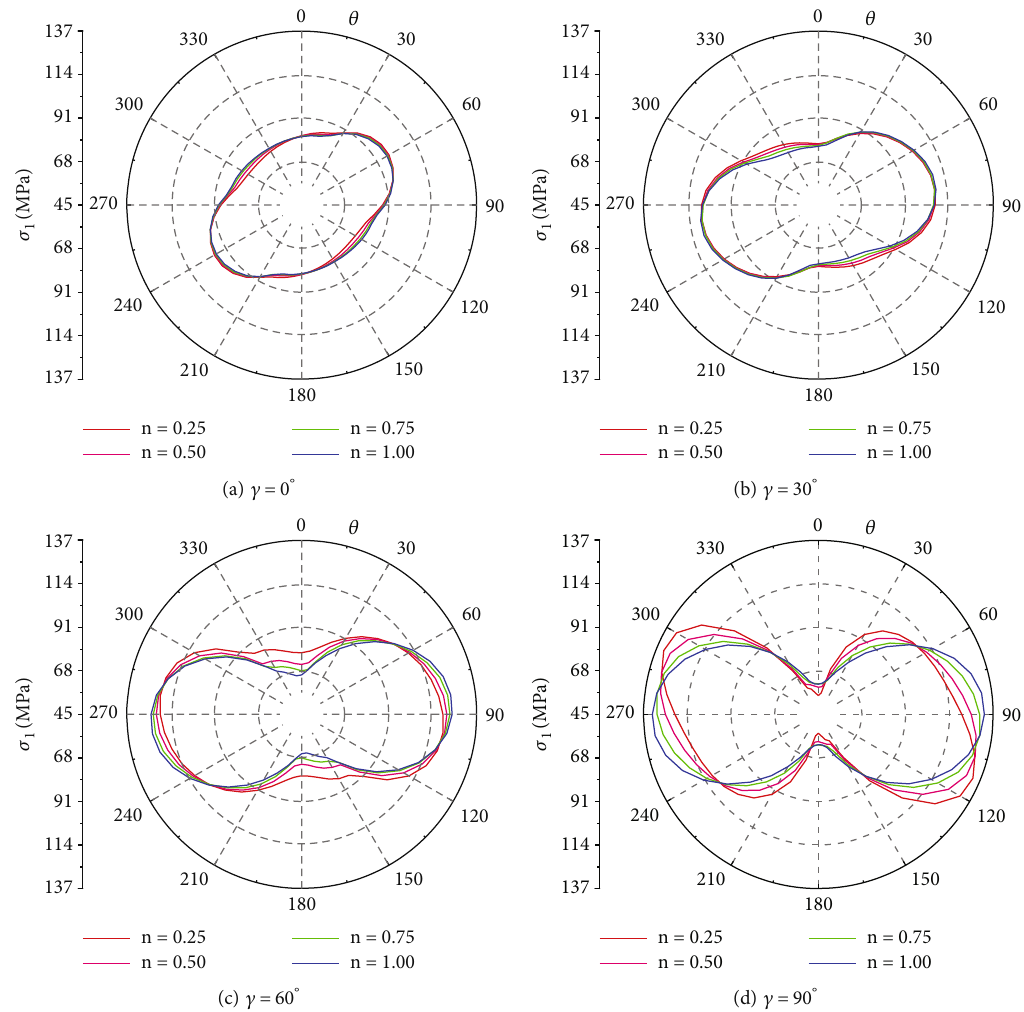
Figure 8: The maximum principal stress distribution due to di ff erent ratios of elastic